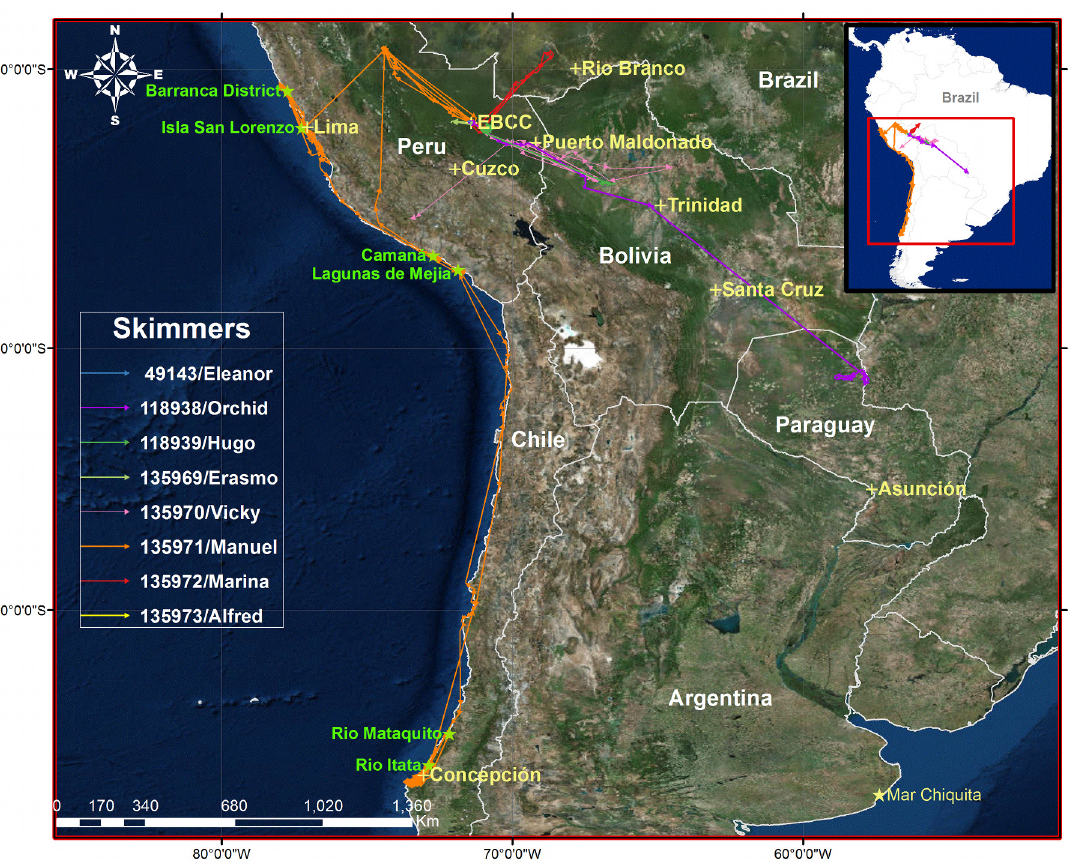
Fig 1. Long-distance movements of Black Skimmers tagged in Manu National Park, Perú, 2012 – 2014. Tracks of 8 skimmers tagged in Manu National Park with arrows denoting received locations and direction of travel. Pacific coast stopovers used by Manuel (orange track) for > 48 h noted with green stars. Created with ESRI ArcGIS 10.2.2 software. Basemap data sources include: Esri, DigitalGlobe, GeoEye, Earthstar Geographics, CNES/Airbus DS, USDA, USGS, AEX, Getmapping, Aerogrid, IGN, IGP, swisstopo, and the GIS User